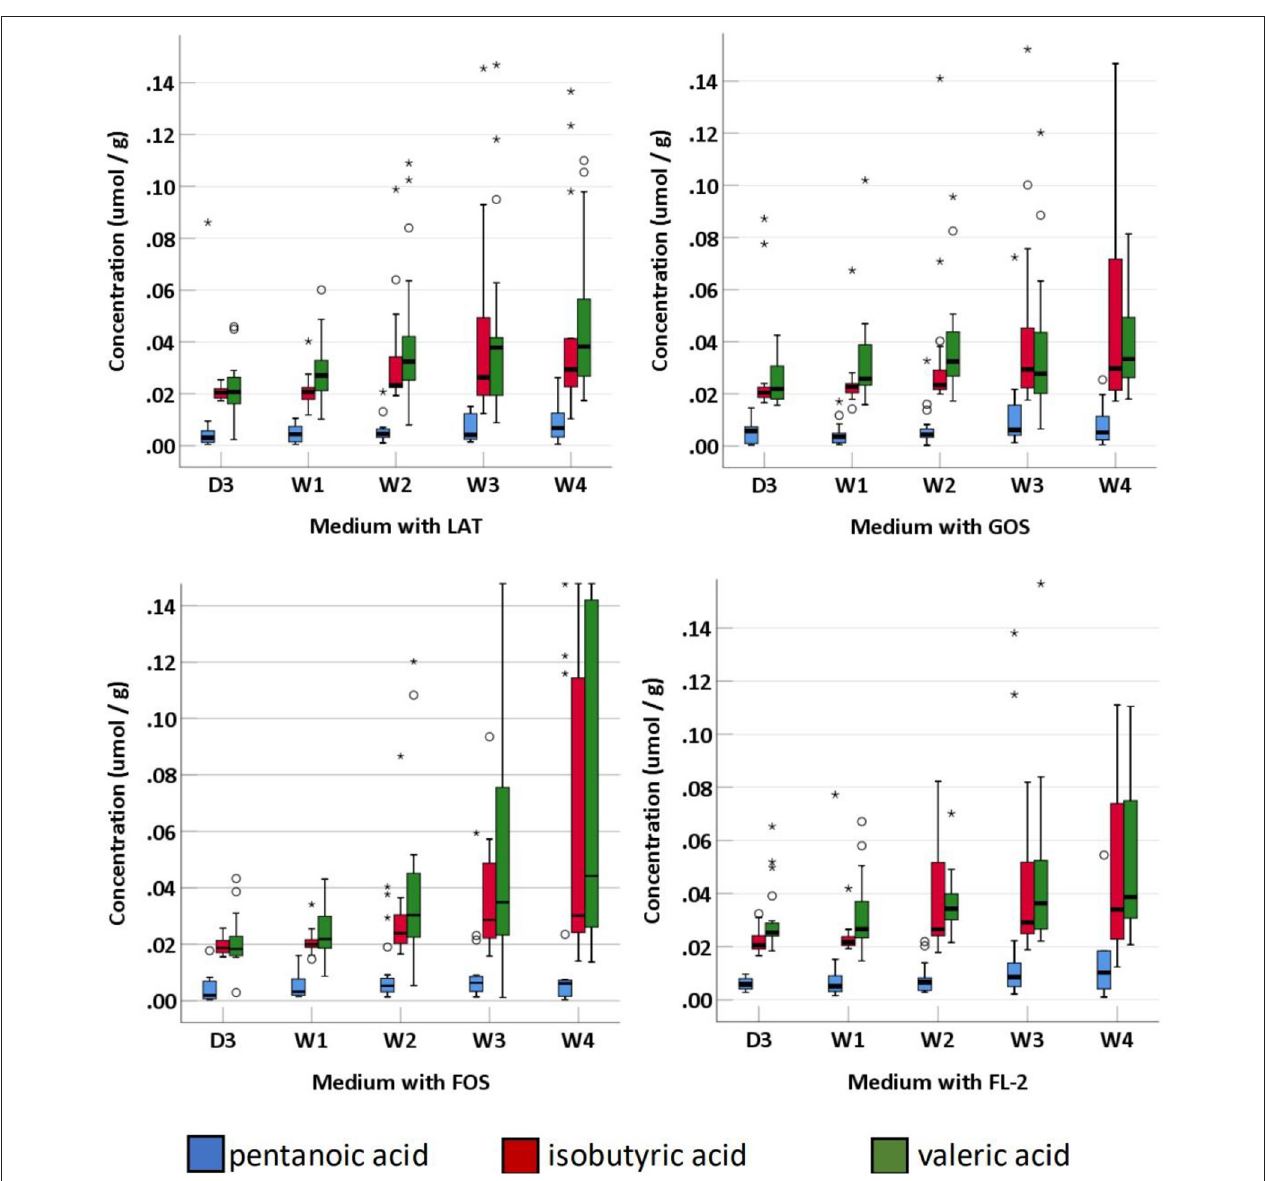
FIGURE 4 | The concentration of fecal SCFAs (pentanoic acid, isobutyric acid, and valeric acid) of preterm infants of different ages. D3, 3 days after birth; W1, 1 week after birth; W2, 2 weeks after birth; W3, 3 weeks after birth; W4, 4 weeks after birth; LAT, lactose; FOS, fructooligosaccharide; FL-2, milk oligosaccharide; GOS, galactooligosaccharide; *, extreme value; ◦ , discrete value; SCFAs, short-chain fatty